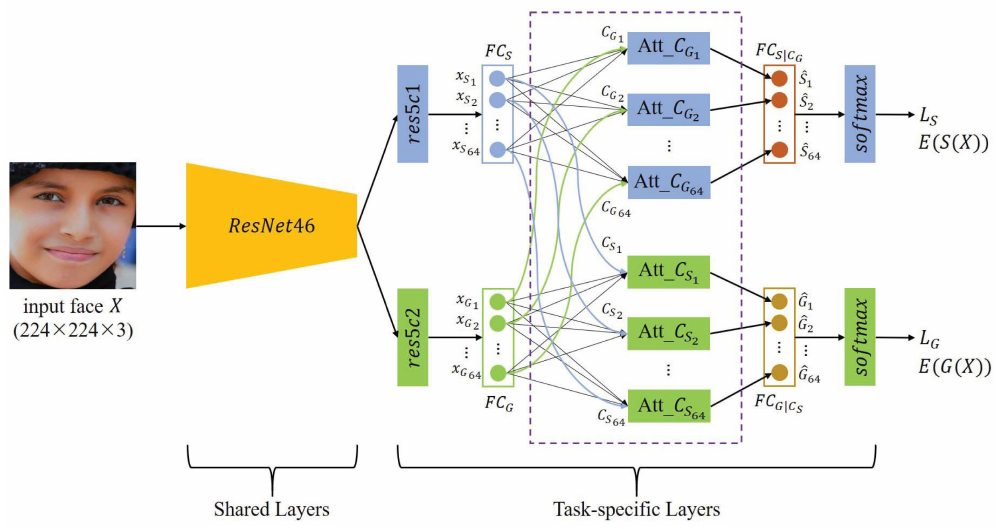
Figure 2. The architecture of the proposed multi-task learning convolutional neural